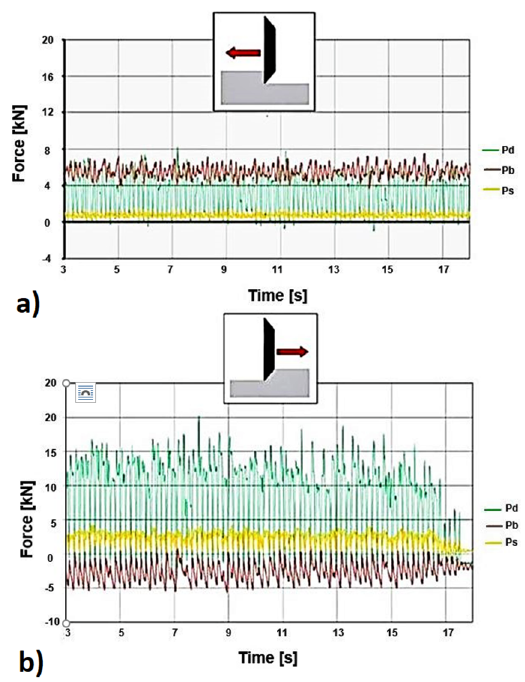
Figure 15. Courses of values of pressure Pd, cutting Ps and side Pb forces during mining at mining depth of g 10 m: ( a ) to the left, ( b ) to the right [30].